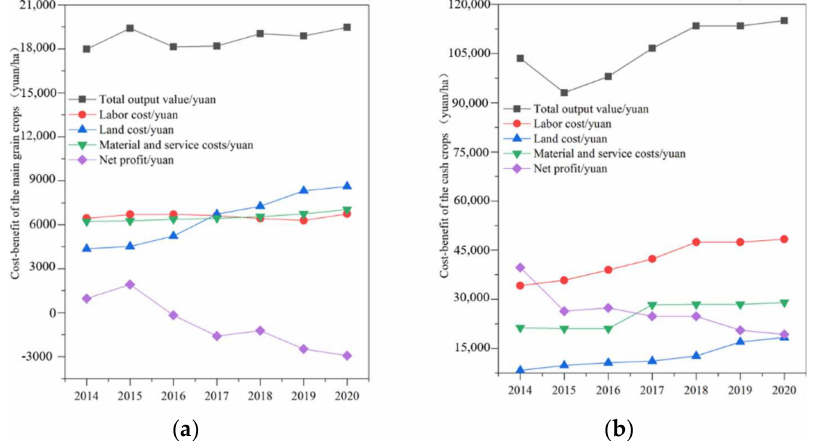
Figure 5. Cost–benefit comparison of cultivated land per ha under different utilization modes: ( a ) cost–benefit of the main grain crops; and ( b ) cost–benefit of the cash